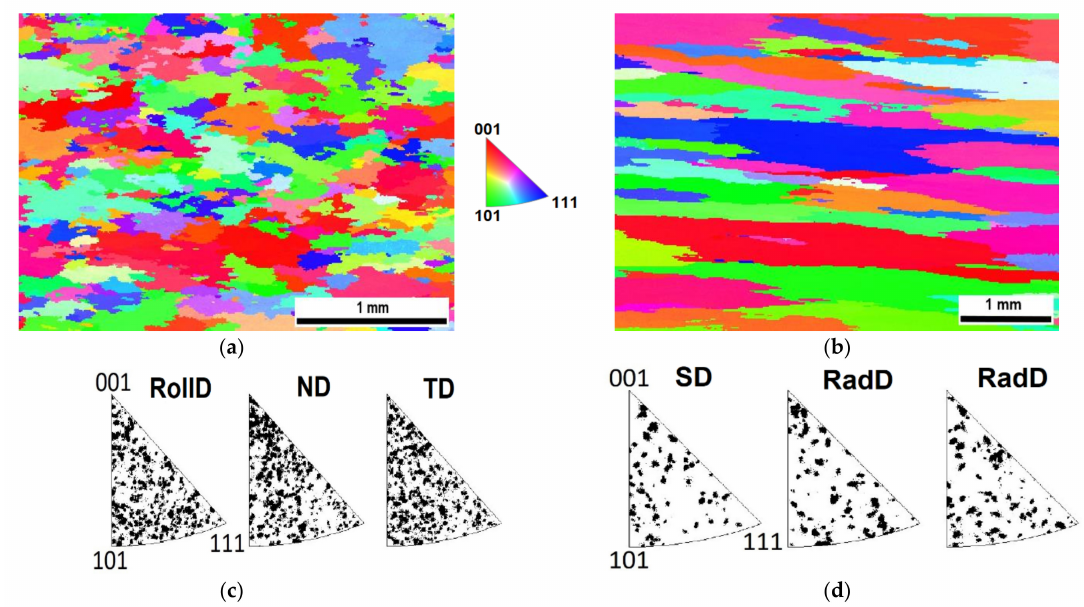
Figure 5. Comparison of grain microstructures after secondary recrystallization ( a ) Specimens I in RollDxND plane; ( b ) Specimens II in SDxRadD plane, scanning electron microscopy (SEM)–electron backscatter di ff raction (EBSD) inverse pole figures for ( c ) Specimens I; ( d ) Specimens II.